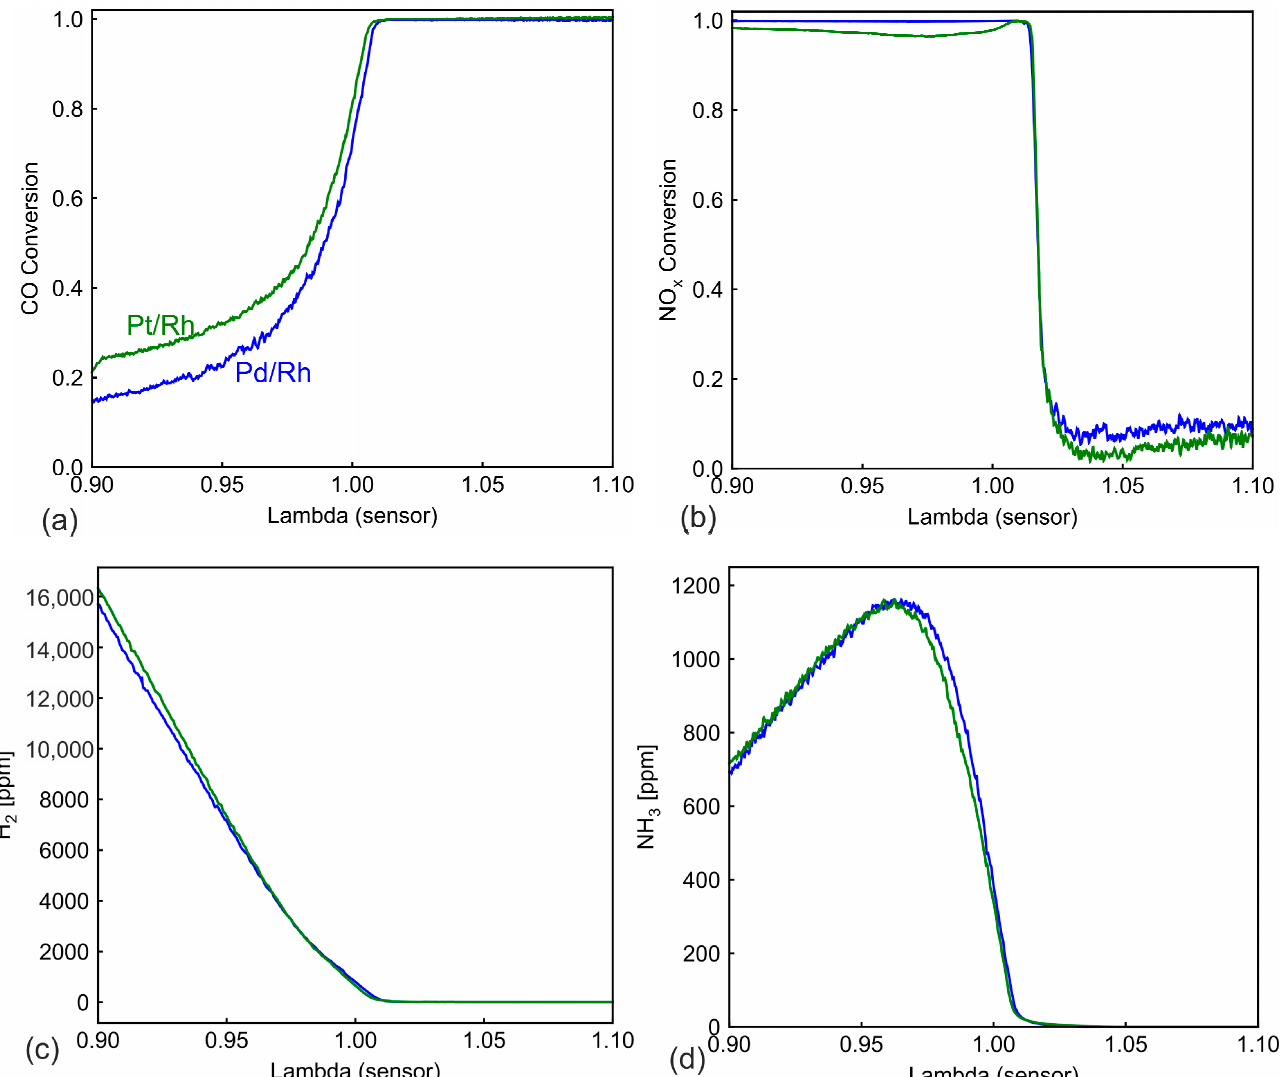
Figure 3. Comparison of ( a ) CO conversion ( b ) NO x conversion in the Pt/Rh and the Pd/Rh catalyst and ( c ) H 2 concentration and ( d ) NH 3 concentration downstream the catalysts during λ ramp-up at 520 °C.